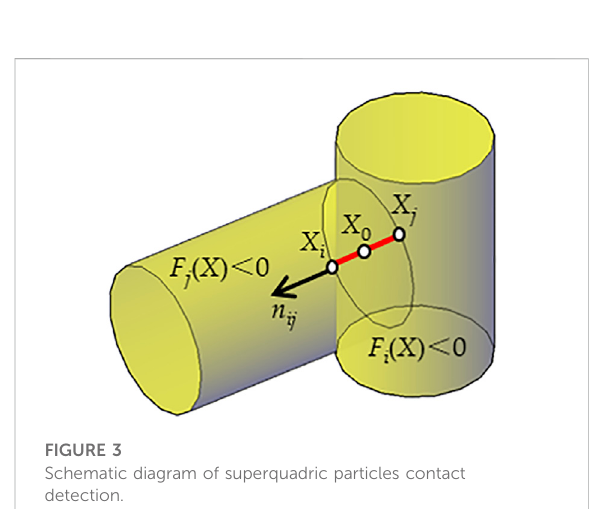
FIGURE 3 Schematic diagram of superquadric particles contact detection.